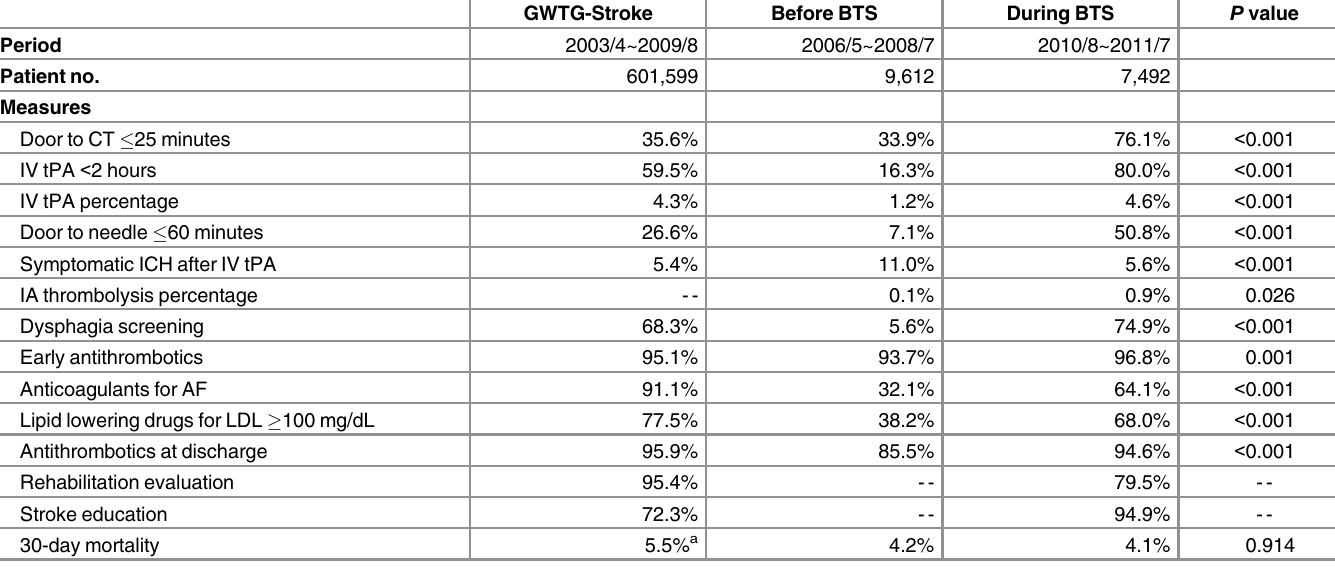
Table 2. Comparison of Quality Measures from 14 Hospitals in Group I Before and During BTS-Stroke Activity and the GWTG-Stroke in USA (2003 – 2009).